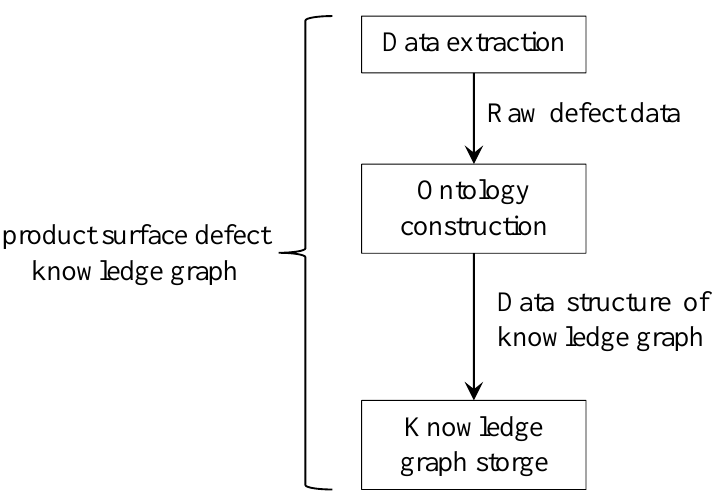
Figure 7. Research framework for the construction of knowledge graphs in the field of product sur- face defect.